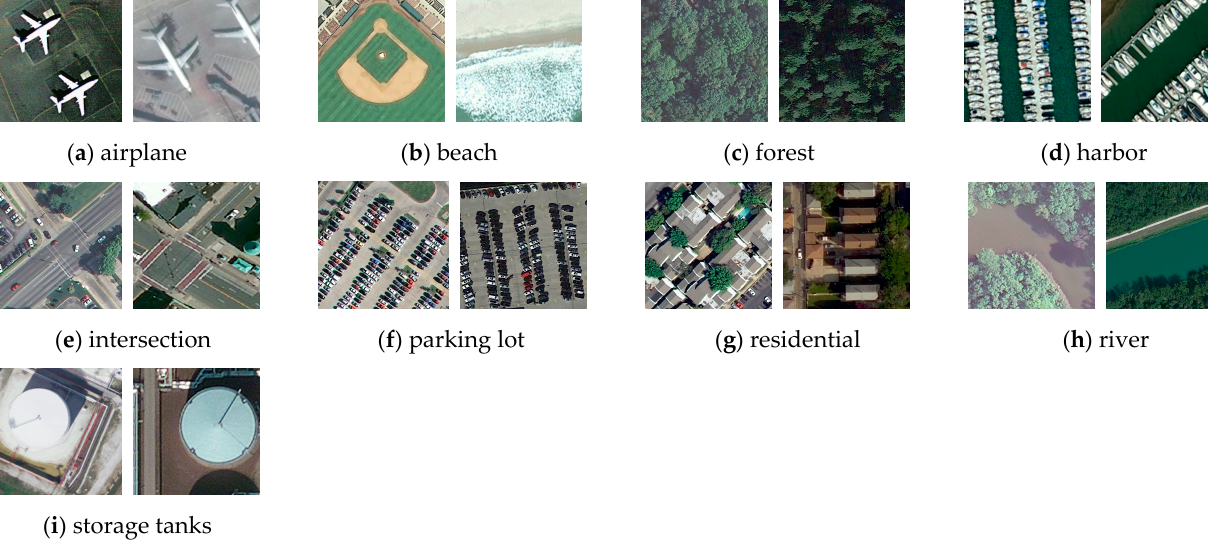
Figure 9. Samples of each common class for UCM ( left ) and RSI-CB256 (RSI) ( right ).